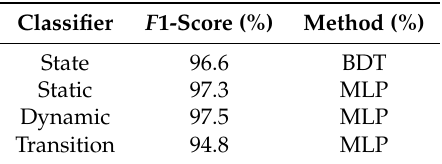
Table 4. F 1-scores of the classification methods for the different classifiers: Boosted Decision Trees (BDT), Multilayer Perceptrons